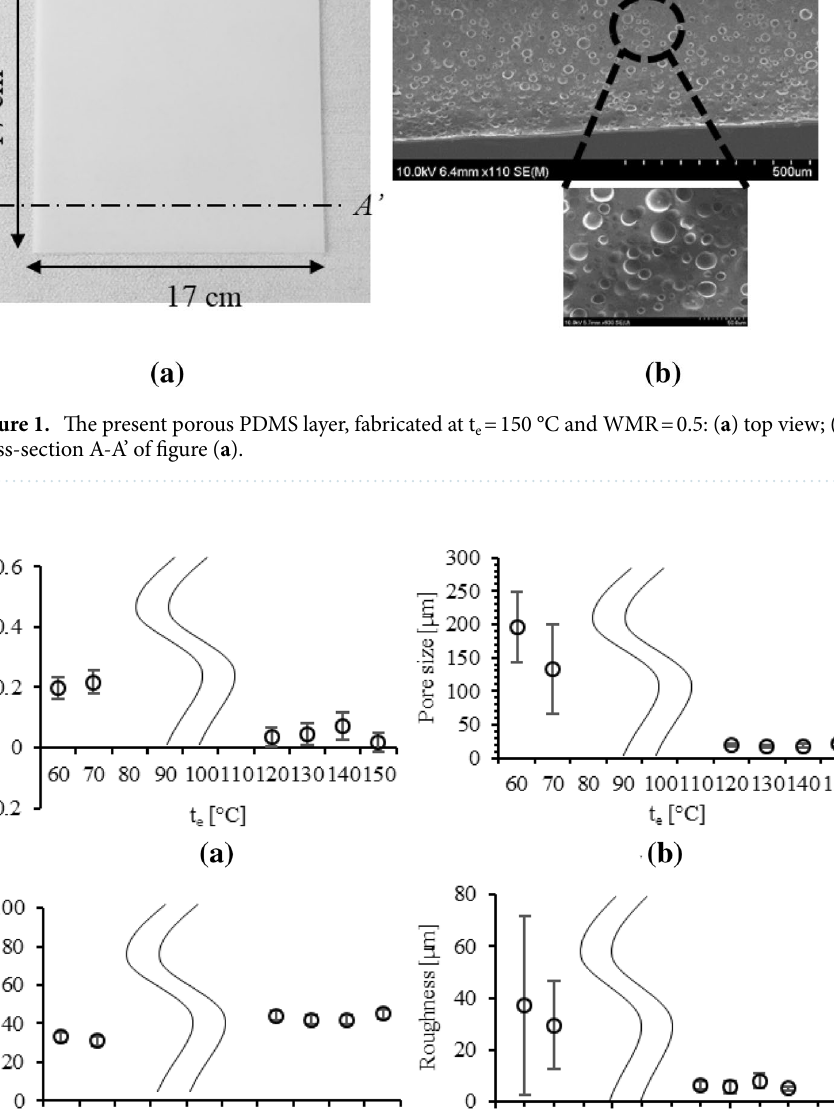
contractions are increased depending on WMR (Fig. 3a). The volumetric contractions, fabricated at WMR = 0.5, 1.0, 1.5, and 2.0 are 0.03 ± 0.023, 0.16 ± 0.060, 0.35 ± 0.021, and 0.43 ± 0.064, respectively. Pore size and shape. The two solvent of the porous PDMS layer, ethanol (boiling point = 78.4 °C) and toluene (boiling point = 110.6 °C), are both boiled over the temperature of 120 °C. t e over 120 °C increases the evaporation speed of the solvent mixture of the ethanol and the toluene by boiling, thus reducing the pore size and increasing the pore size uniformity. The pore sizes are 160 ± 67 µm and 20 ± 2.9 µm, fabricated at t e in the range of 60–70 °C and 120–150 °C, respectively (Fig. 2b). The pore size uniformity based on coefficient of vari-